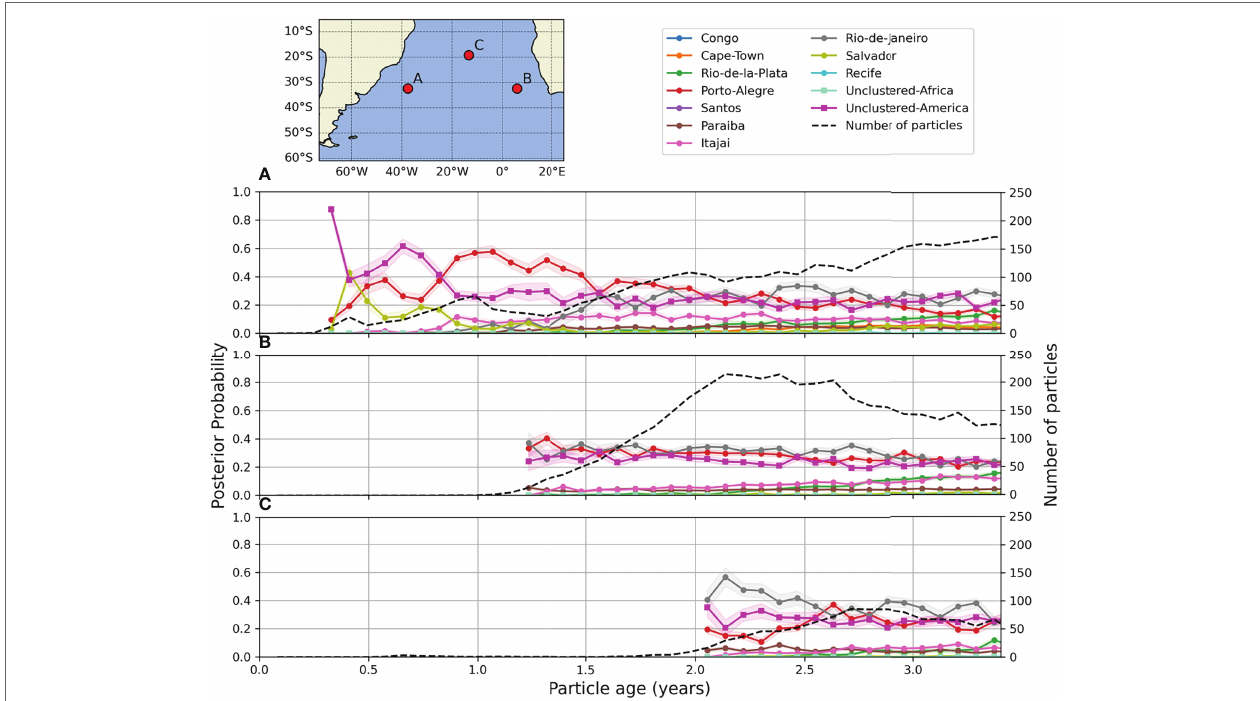
FIGURE 4 | Local posterior age distributions at three different locations for the posterior probability. The map on the top right marks the locations (A−C) , that correspond to the time series shown in the plots (A−C) . Each color in (A−C) , represents the probability p ( R i | S loc ) for a particular cluster. The color shading shows the standard deviation associated with the probabilities. The black dashed line represents the number of particles ( N ) at the respective